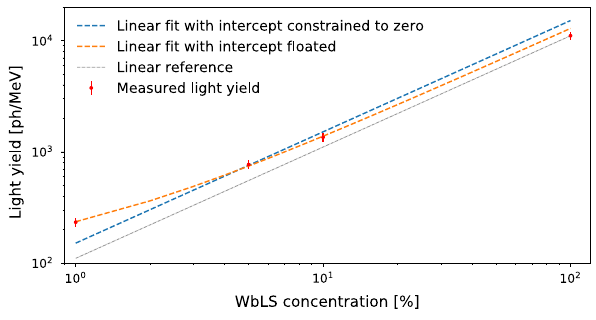
Fig. 3 Measured absolute scintillation light yield as a function of con- centration (red dots, displaying the total uncertainty), including pure LAB-PPO2g/L(100%concentration).TwolinearfitstothethreeWbLS points are shown, one with the intercept constrained to zero (blue) and anotheronefreelyfloatingtheintercept(orange).Forreference,amodel linear with the pure LABPPO 2/L light yield and with zero intercept is shown